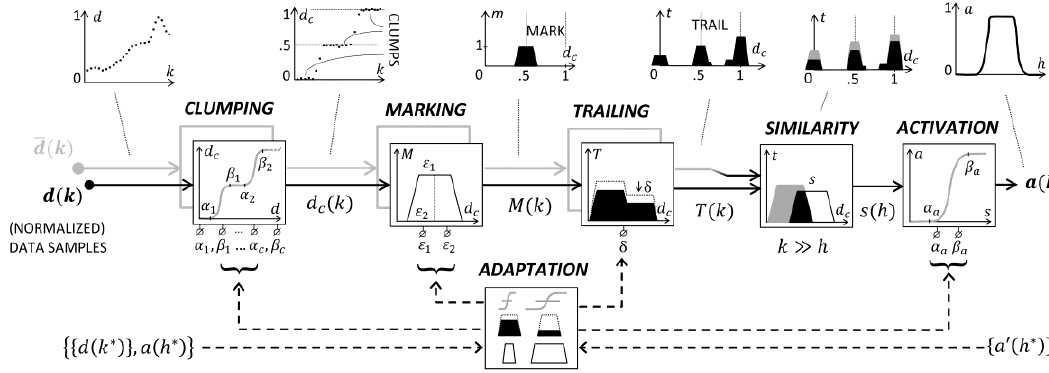
Figure 3. Structure of a Stigmergic Receptive Field.